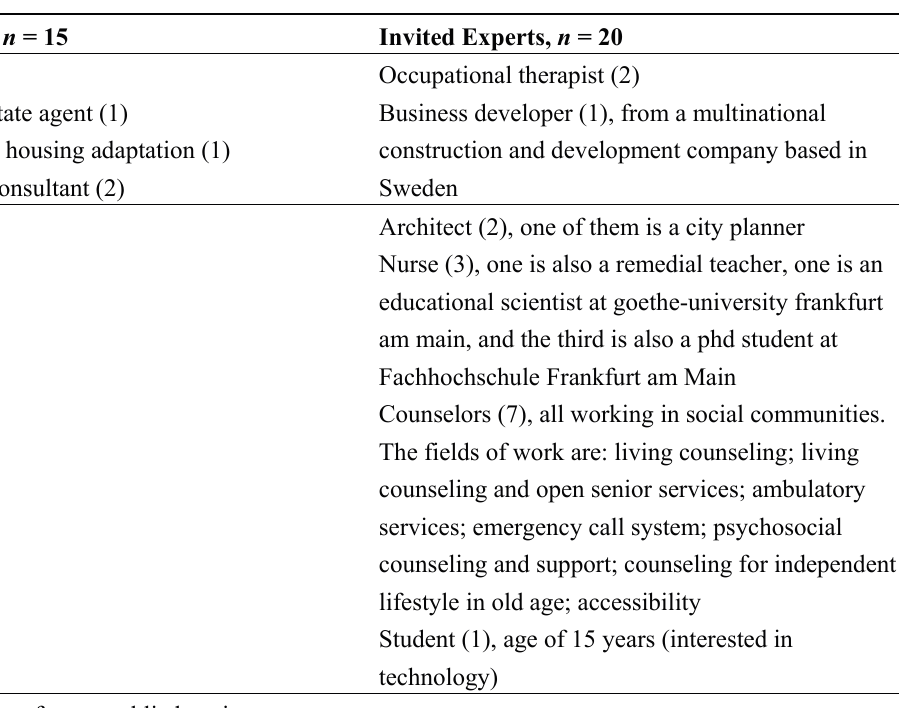
Table 2 . Professionals in the research circles and experts invited to single meetings, n =